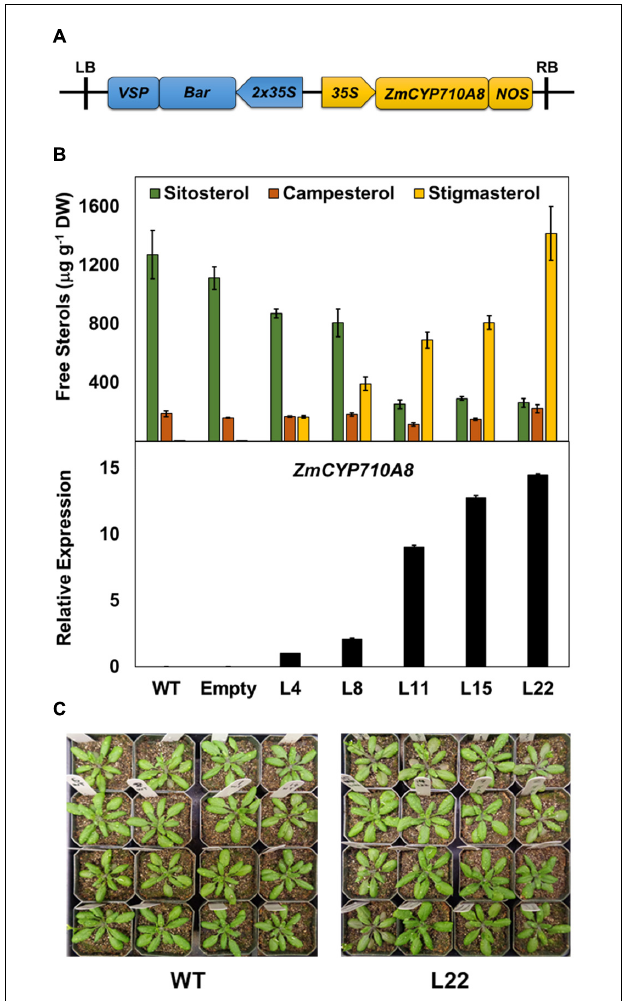
FIGURE 2 | Heterologous expression of ZmCYP710A8 in Arabidopsis increases stigmasterol at the expense of sitosterol. (A) Schematic of the T-DNA region of the molecular construct used to overexpress the presumed coding region of ZmCYP710A8 sequence in Arabidopsis thaliana Col-0 background. LB, left border; RB, right border; 35S, cauliflower mosaic virus constitutive promoter; Bar, phosphinothricin N-acetyltransferase gene as selectable marker; VSP, vegetative storage protein terminator; NOS, nopaline synthase terminator. (B) Free major sterol contents of transgenic Arabidopsis thaliana rosette leaves expressing the maize gene ZmCYP710A8 in Col-0 background. Also shown, in the bottom panel, is the quantification of ZmCYP710A8 mRNA in the rosette leaves relative to AtEF1 α -A (used as a reference gene for normalization). WT, Col-0 wild type; Empty, Col-0 transformed with empty vector; L4, L8, L11, L15, and L22 are five independent transgenic events. Tissue samples were pooled from rosette leaves of 10 individual plants (4-week-old) for each line, split to do both sterol and mRNA analysis. Sterol measurements are shown as means ± SD from four technical replicates. mRNA measurements are shown as means ± SD from three technical replicates. (C) Images of 4-week-old wild type and a ZmCYP710A8 overexpressor (L22) Arabidopsis plants are shown.